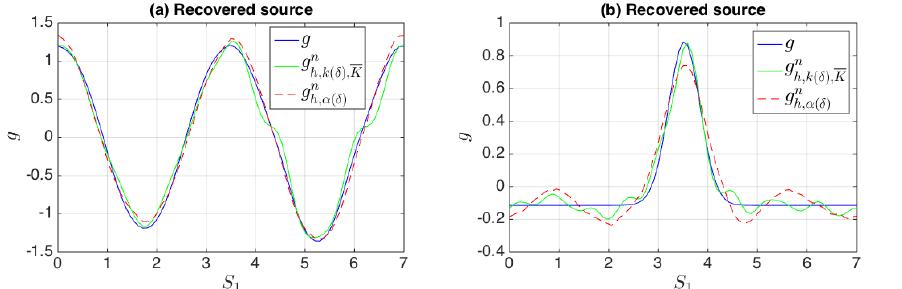
(green) and h , k ( δ ) , K